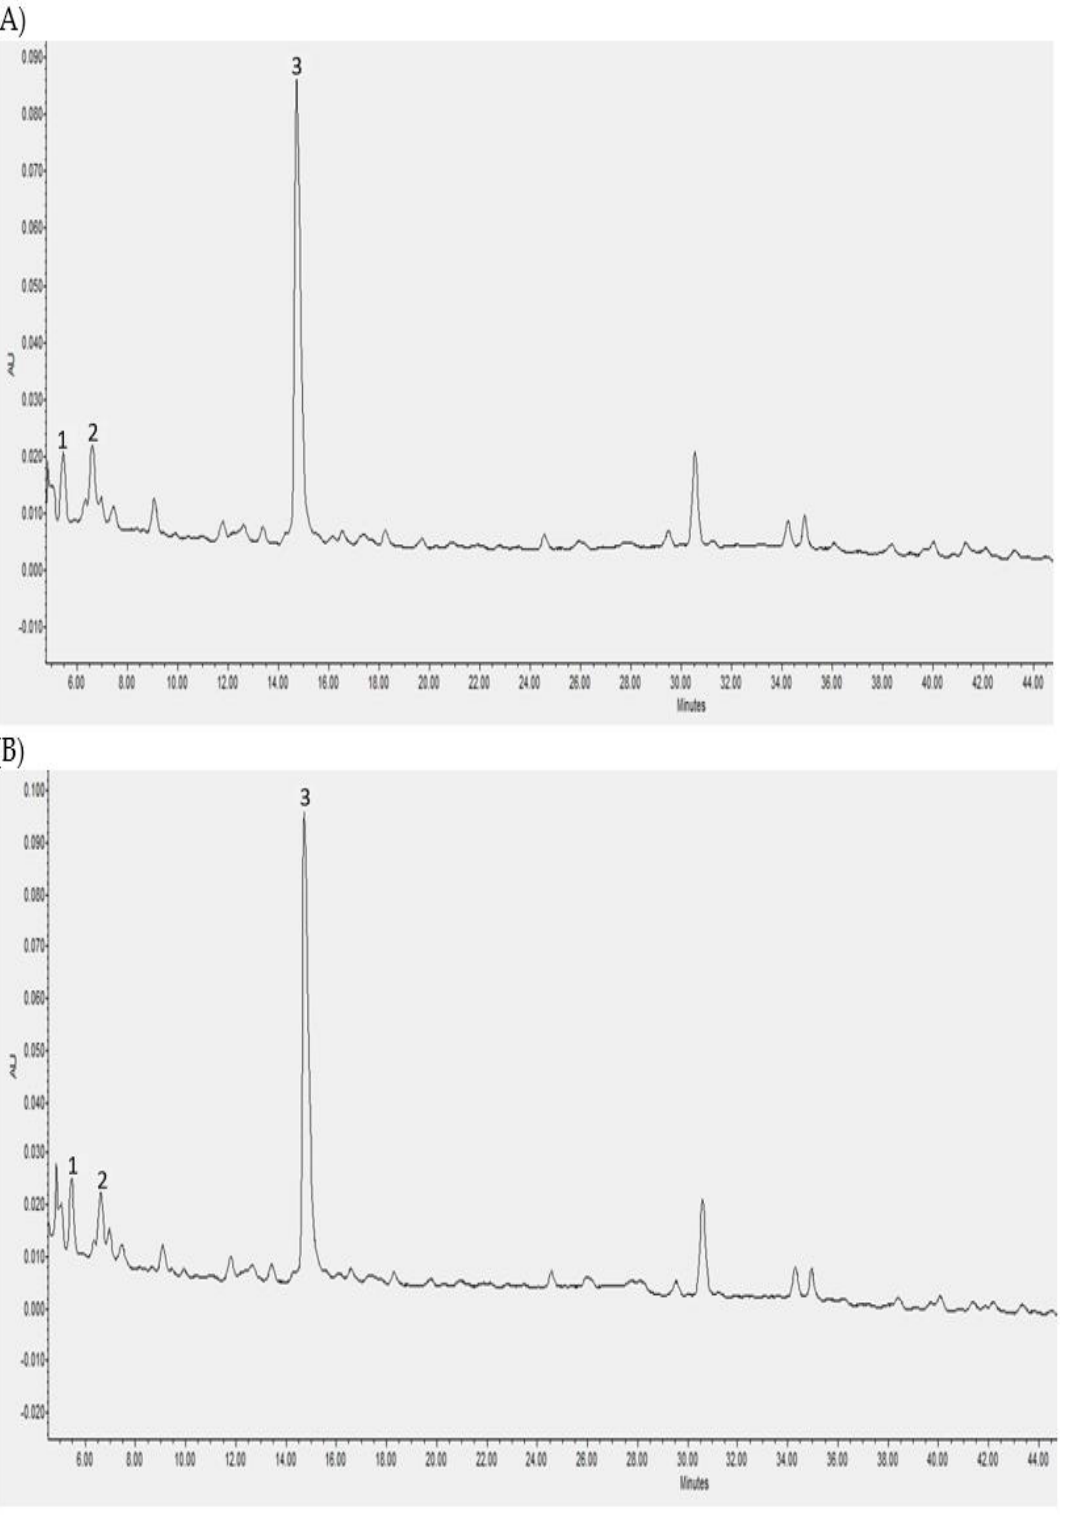
Figure 5. HPLC chromatograms of fermented fractions of lucerne; ( A ) Soluble fraction of lucerne after 12h fermentation, ( B ) Soluble fraction of lucerne after 24h fermentation. Polyphenols identified are (1) Gallic acid, (2) Pyrogallol, and (3) Procyanidin B2.